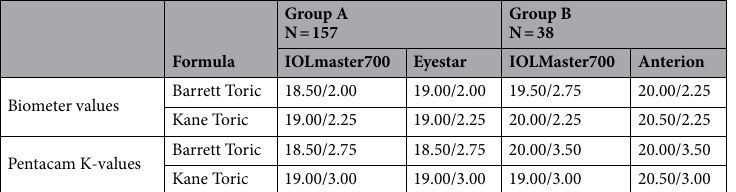
Table 5. Suggested IOL power (diopters) stratified by device. Biometer values: IOL calculations were performed using the Barrett and Kane toric calculators with values obtained by the different biometry devices. Pentacam K-values: The calculations were repeated with the biometers’ K values replaced by the Pentacam K values.